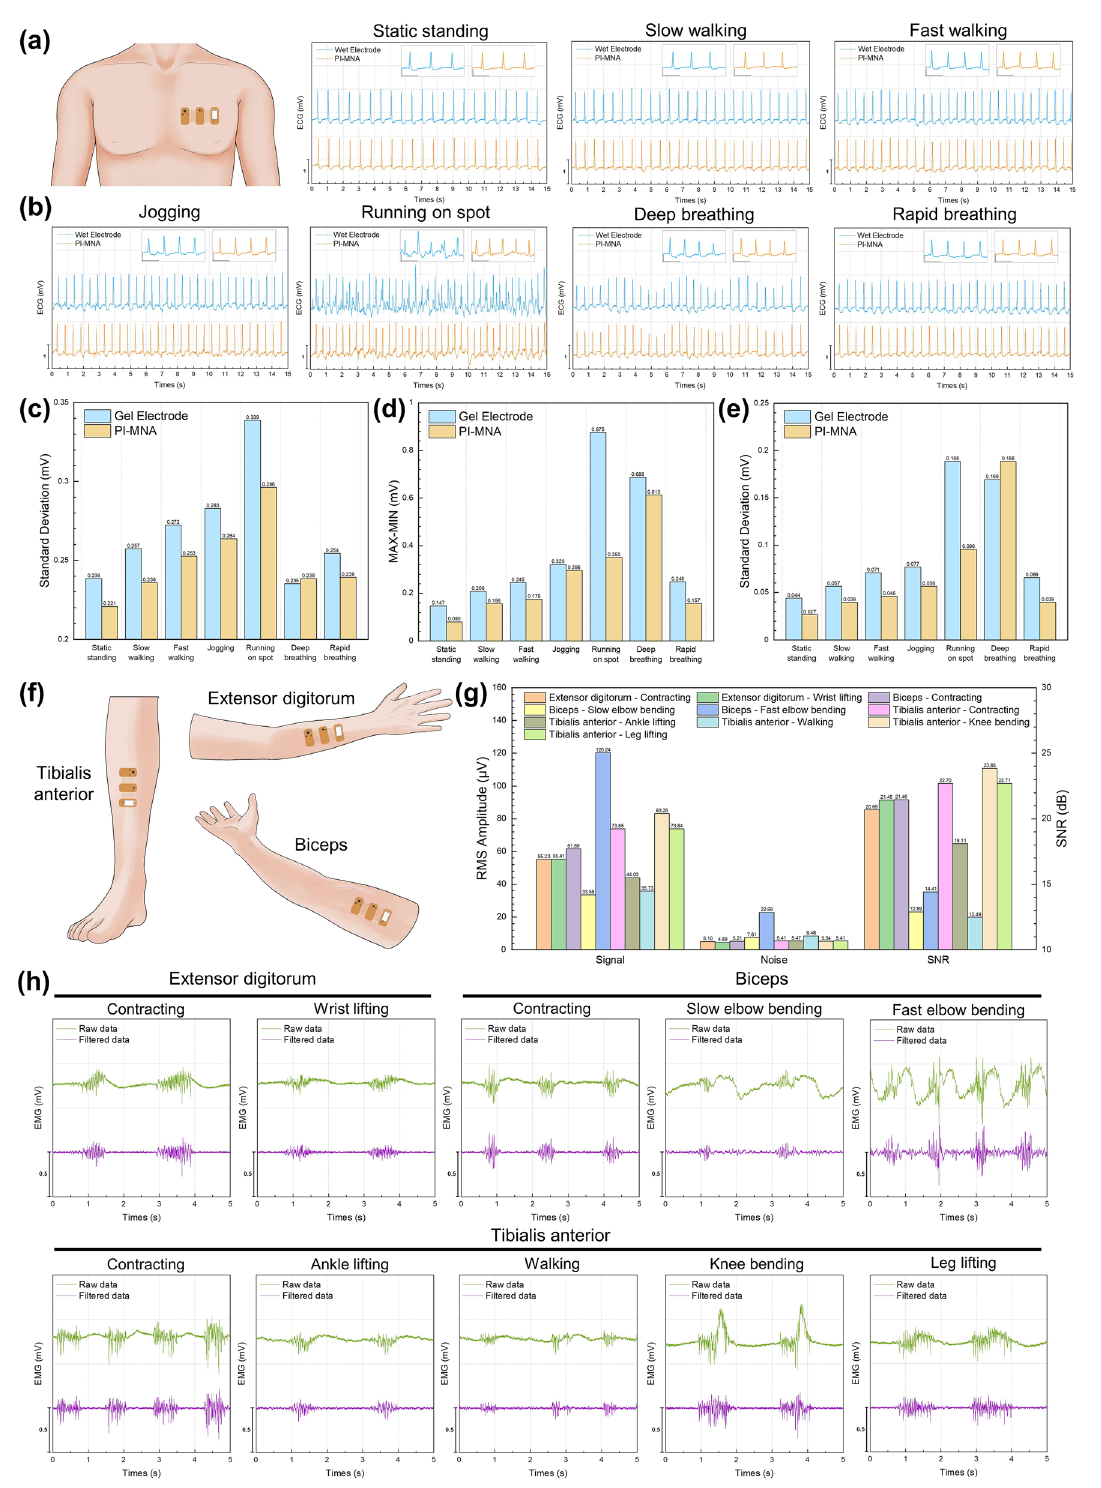
Fig. 5 a Wearing position for ECG wireless recording. b Simultaneous ECG signals recorded during seven different states by the wearable system with the PI-MNA and gel electrodes. The insets in each diagram show the clearer signal segments to visually display the artifacts (scale bar: x—0.5 s, y—0.5 mV). c‑e Quantitative analysis of the motion artifact level of ECG, including c the standard deviation of all data points, d the difference between the maximum and minimum peak values of the QRS complex, and e the standard deviation of the QRS peaks. f Wearing position for EMG wireless recording. g RMS values of signals and noises during recording, as well as the SNR values of EMG signals in 10 different muscle or joint movements. h 5-s segments of EMG